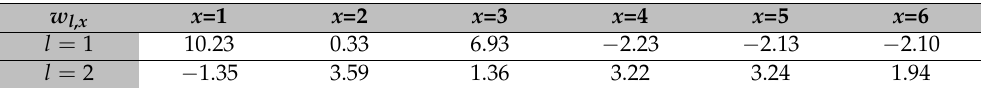
Table 4. Final weight values of the output layer.